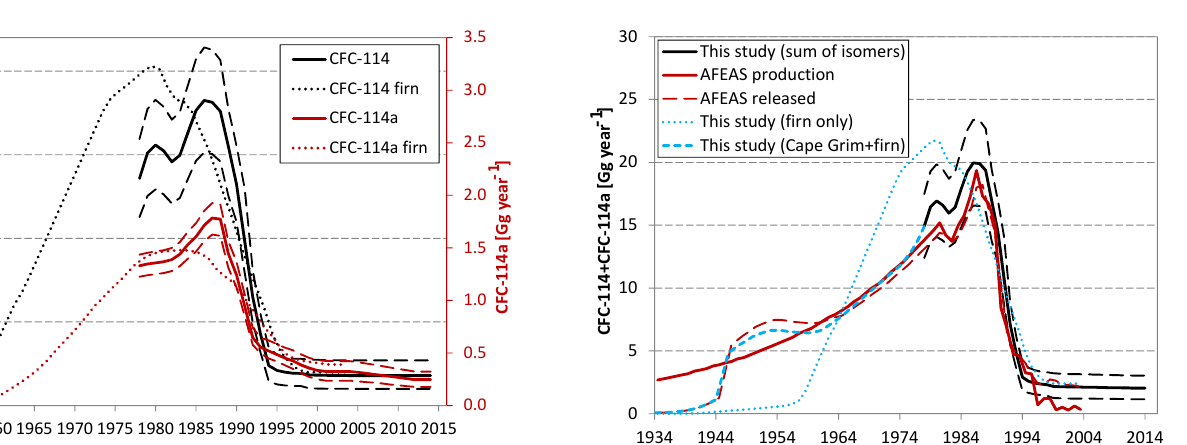
Figure 4. Atmospheric observation-based emissions of the sum of CFC-114 and CFC-114a (black line with black dashed lines repre- senting uncertainty ranges) in comparison with “bottom-up” emis- sions from the AFEAS inventory. The dotted blue line indicates emissions purely derived from firn air observations while the dashed blue line results from matching the firn-based emissions to the Cape Grim-based emission record in 1978 while not leaving the uncer- tainty range of the firn-based mixing ratios from Fig.